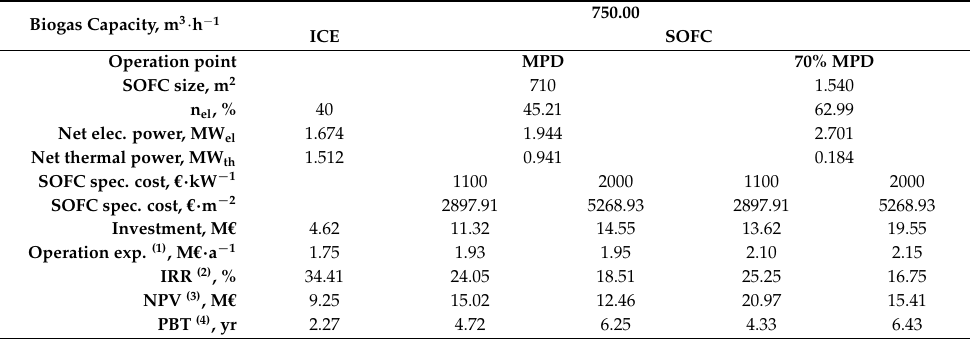
Table 9. Summary of the main operational and economic characteristics, and the feasibility perfor- mance of the larger scale biogas-CHP